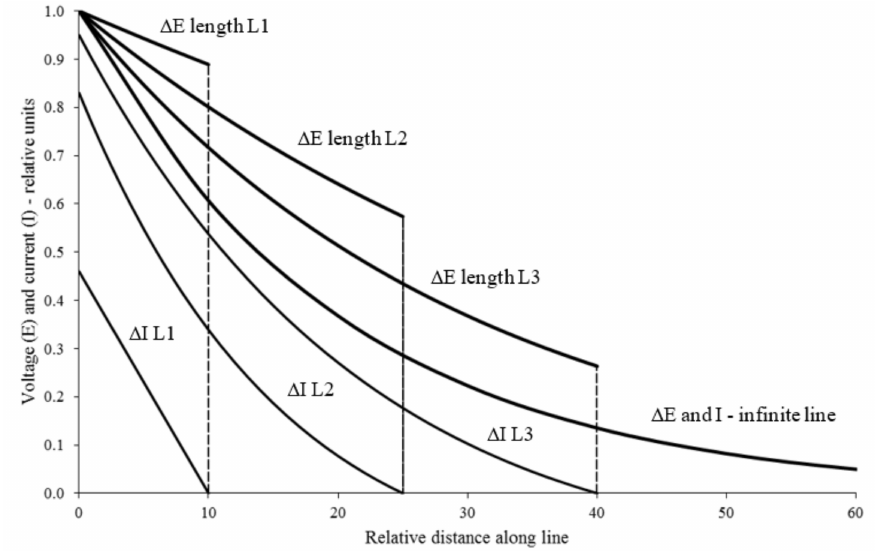
Figure 3. Attenuation curves (relative voltage and current) vs. distance to the draining point (adapted from Reference